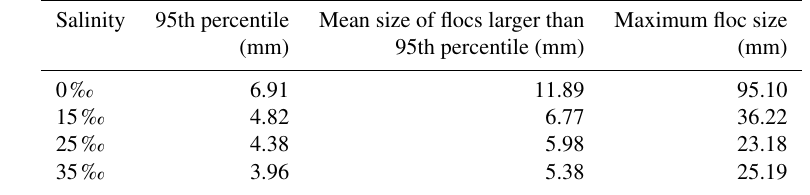
Table 5. Sizes of the largest frazil ice flocs at all four salinities.